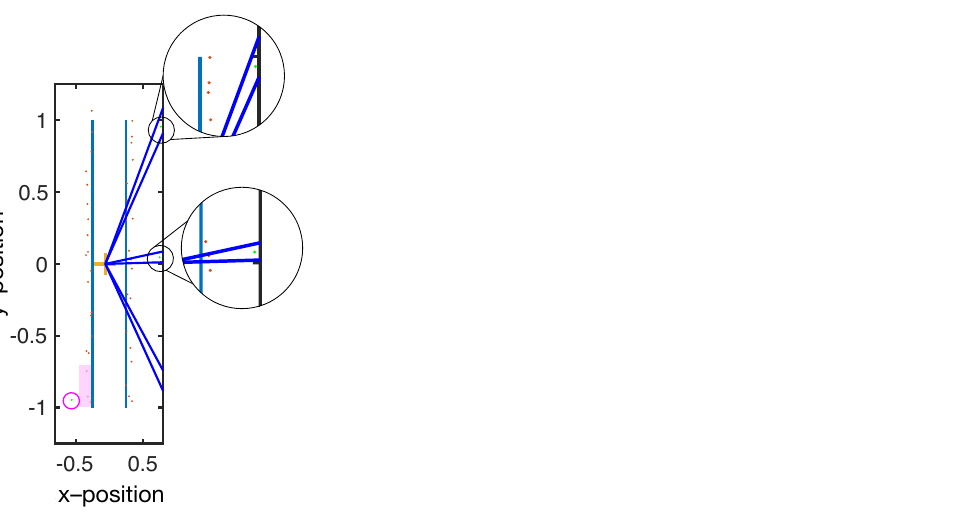
Figure 4. In irregular geometries or when the data density is low, outliers can be selected as valid, as shown in the top inset. The lower inset shows a case where an outlier is rejected. To prevent outliers from being selected, a coarser angular range is used to select points for which the mean distance to the reference is calculated (purple block). The mean is used to exclude points that are more than 20% greater than the mean (magenta circle).